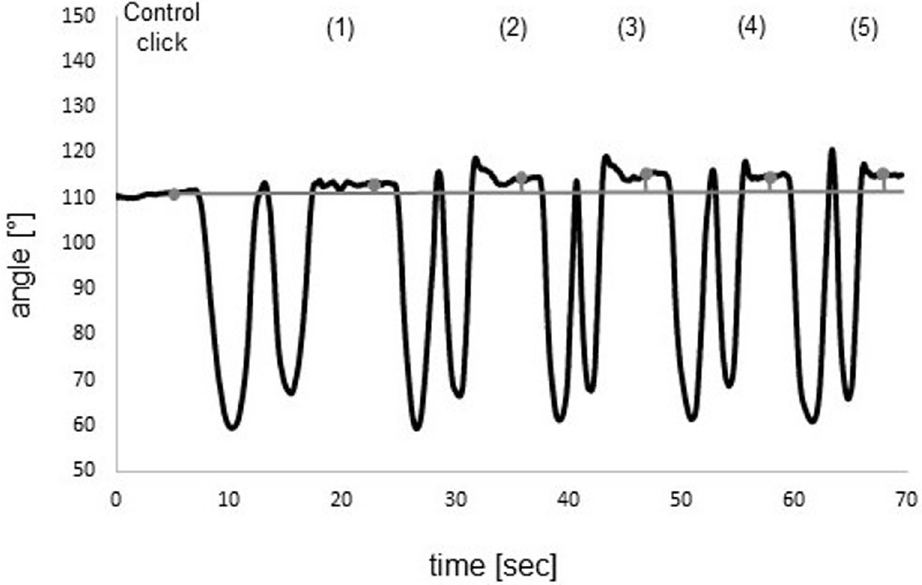
Fig 6. Small deviation in neutral head repositioning. Black line : Row angle between head and chair markers during measurement. Gray line : Control click and five consecutive clicks to confirm position. Deviation from black line to grey line represents the deviation of the row between-marker angle to the control angle. Mean deviation (absolute error): 1.3˚.